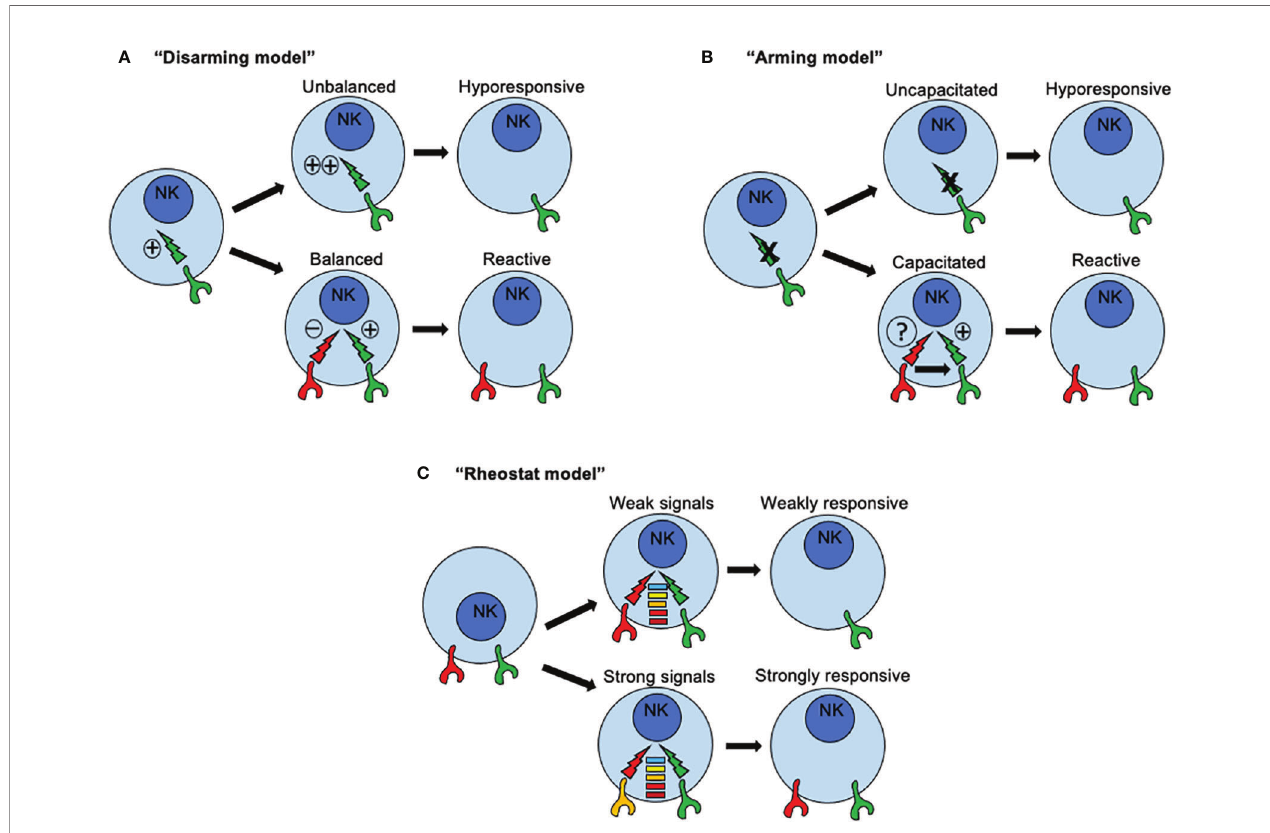
FIGURE 3 | How recognition of MHC class I molecules drive NK cell reactivity and self-tolerance. Three major models have been proposed to explain how NK cells become functionally competent. (A) The fi rst model is based on a “ disarming ” mechanism and propose that activating signals in immature NK cells are by default in “ ON ” mode. If such NK cells acquire inhibitory receptors, then interactions with MHC class I molecules prevent such default “ ON ” mode, NK cell tolerance is set-up and NK cells mature normally. However, if such NK cells fail to express inhibitory receptors for self-MHC-I, then prolonged or unopposed activation signals would lead eventually to a state of NK cell hypo-responsiveness. (B) The second model, based on a “ licensing ” or “ arming ” mechanism, sustains that activating signals are by default in “ OFF ” mode. When NK cells acquire the expression of inhibitory receptors for self-MHC-I, then the signaling through such inhibitory receptors capacitate activating receptors to become functionally competent. If NK cells fail to express inhibitory receptors, then the activating receptors would remain functionally incompetent. (C) A third model known as the “ rheostat ” model has been proposed to explain how NK cell responsiveness in regulated during NK cell development According to this model, NK signals are not displayed as a binary system ( “ on ” or “ off ” ), but as an analogue system. The latter means that NK cell responsiveness can be “ tune up ” or “ tune off ” in a quantitative rather than in a binary manner depending on the inhibitory signal triggered by any particular inhibitory receptor for self- MHC class I